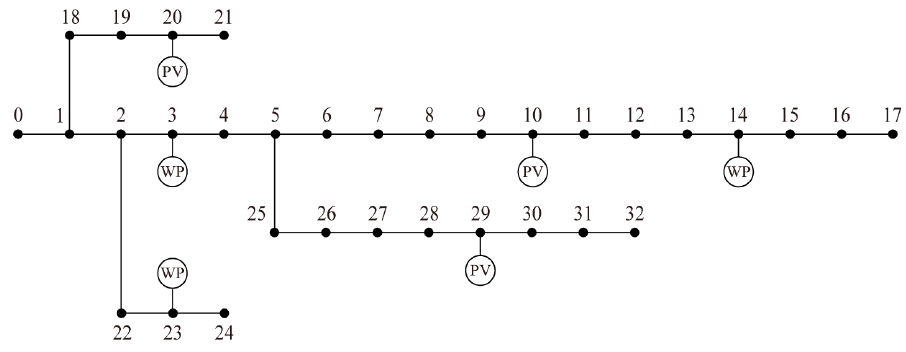
Figure 6. IEEE 33 bus distribution system.